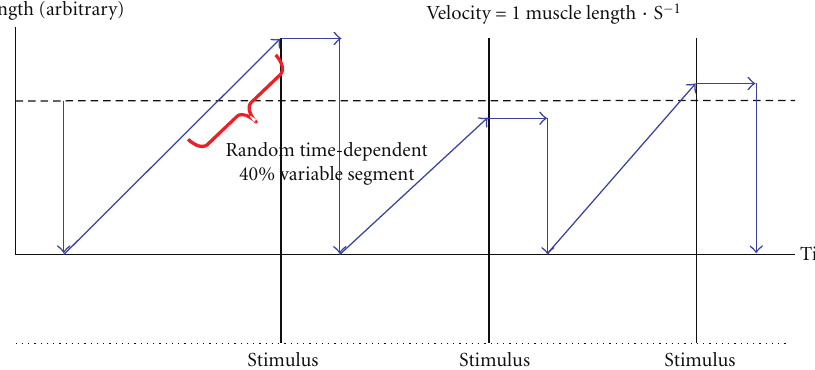
Figure 1: Following a stimulus, muscle length ( y -axis) is kept constant till well after peak active force development has been reached. At 150ms after the stimulation, muscle length is quickly reduced to 90% of optimal length and thereafter restretched at 1 muscle length per second. The duration of this stretch varied resulting in successive beats with di ff erent preloads, where the preload is increased linearly with the interbeat duration.